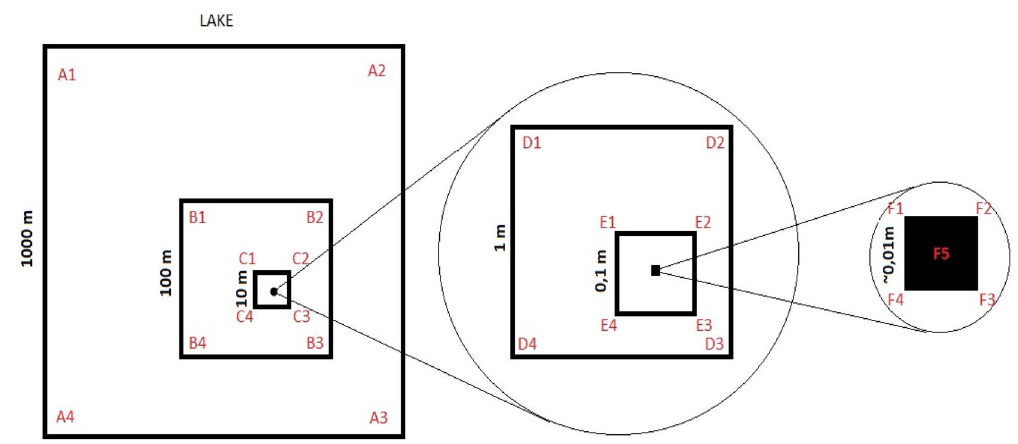
Figure 1. Sampling grid. Designed inside the Lago Negro area, A1-F5 represents the sampling points. (Adapted from (Horner-Devine 2004)).